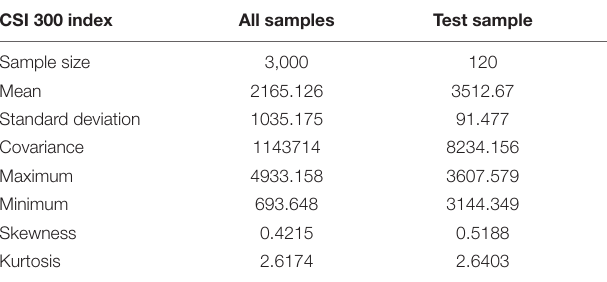
TABLE 1 | Statistical description of the closing price.